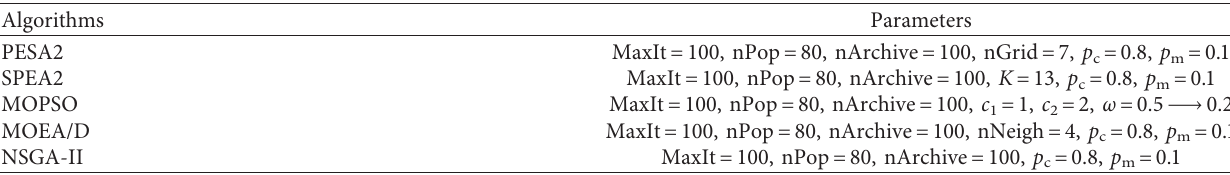
Table 2: Parameters of algorithms. Algorithms